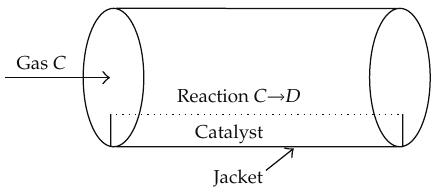
Figure 4: Sketch of a catalytic packed-bed